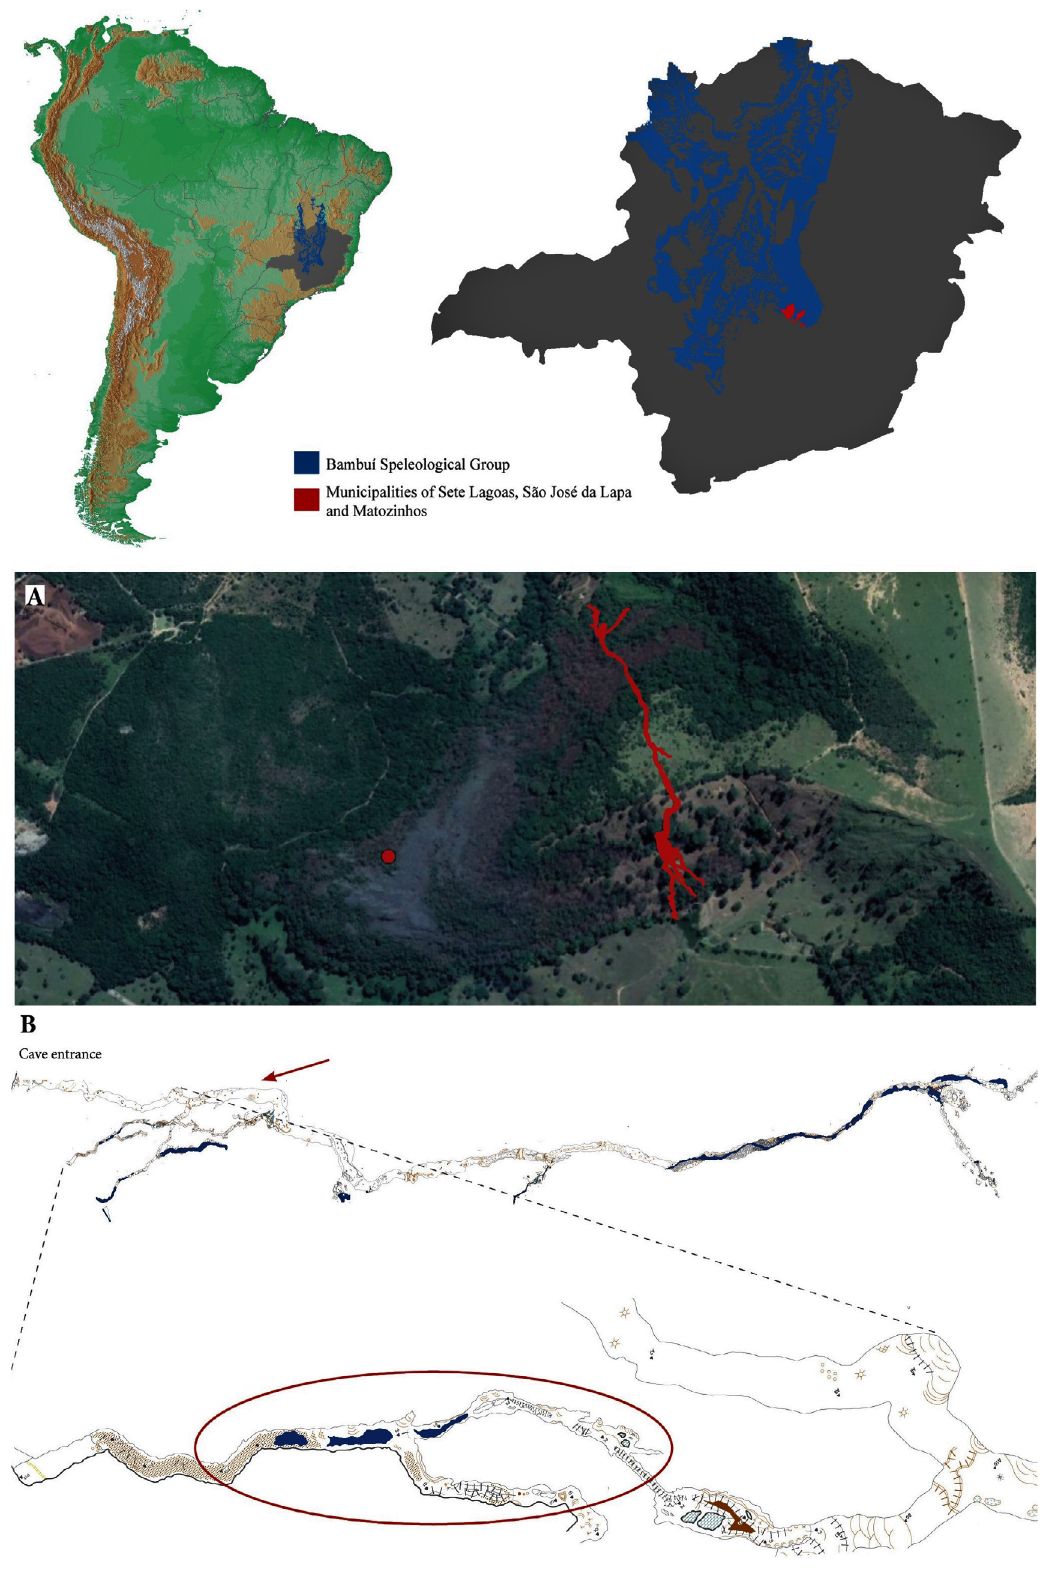
Figure 1. A . Taboa Cave shape highlighted in red in the aerial photograph of the region (municipality of Sete Lagoas, state of Minas Gerais, Brazil) and Tatuzinhos cave indicated by the red dot; B : ground floor of Taboa cave indicating where individuals of Spelunconiscus septemlacuum sp nov. were collected, the red arrow indicates the place where one individual was observed once, far from the region where the isopods were commonly